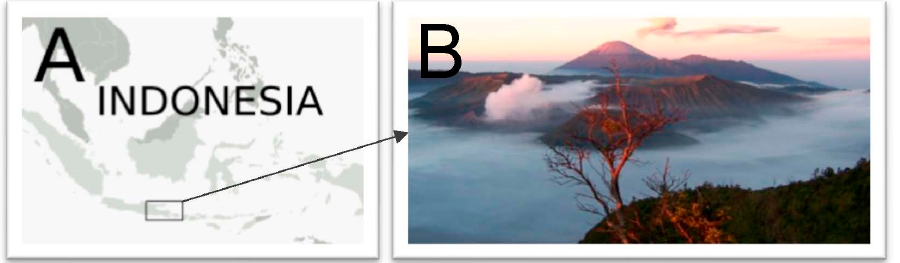
Figure 1. Map of Indonesia. ( A ) Location of Tengger community within a Javanese island. ( B ) Bromo mountain range where Tenggerese community live.